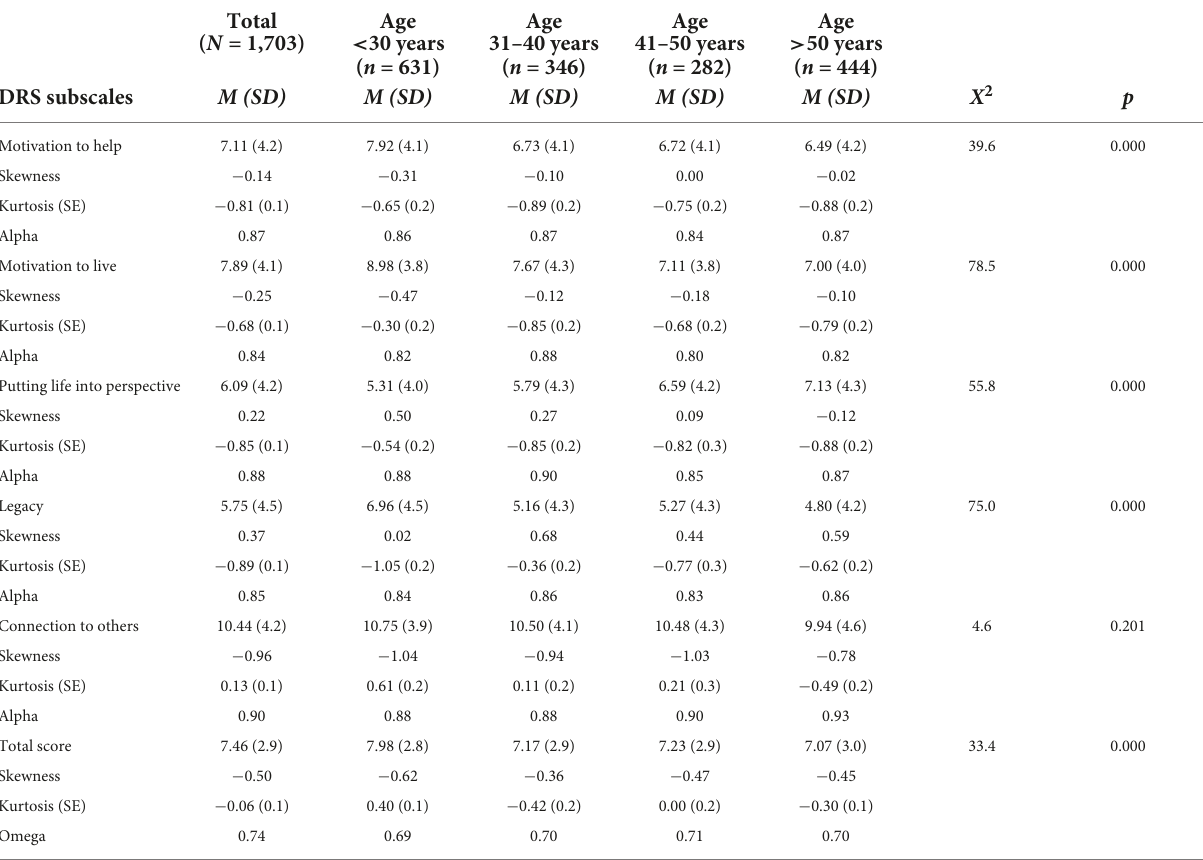
TABLE 2 The Death Reflection Scale items and scale descriptives in different age